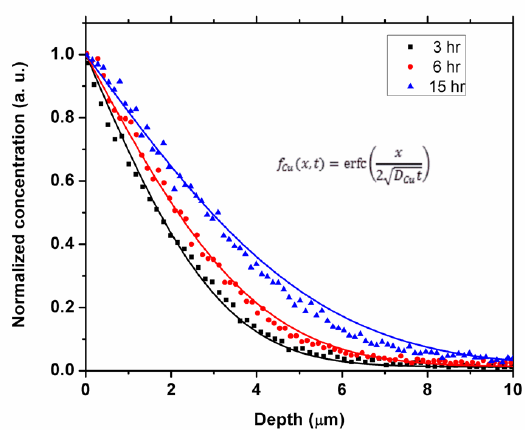
Figure 2. Normalized fitting to the experimental profiles of in-diffusion of Cu in ZnO at 1000 °C for 3h, 6h and 15h.